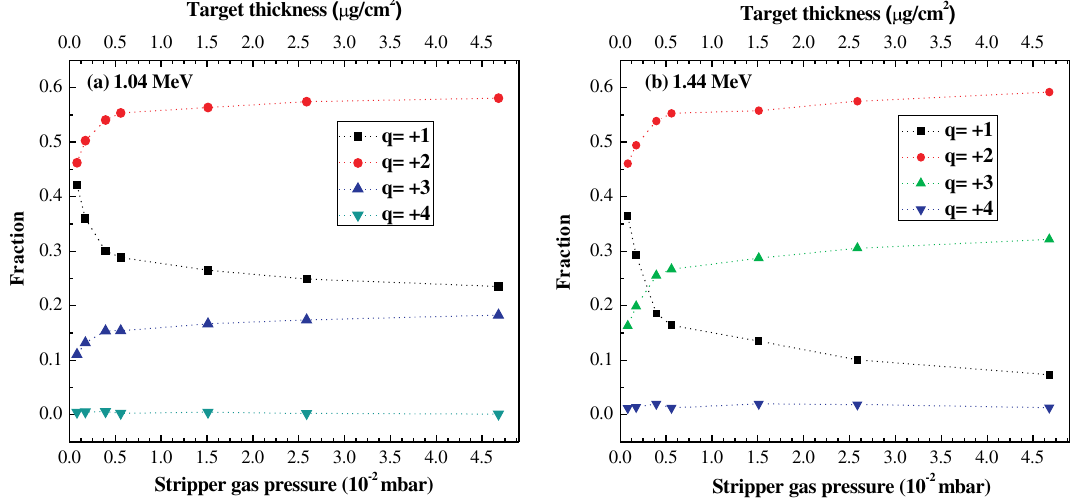
FIG. 3. Variation of different charge state fractions with stripper gas pressure: (a) incident ion energy 1.04 MeV, (b) incident ion energy 1.44